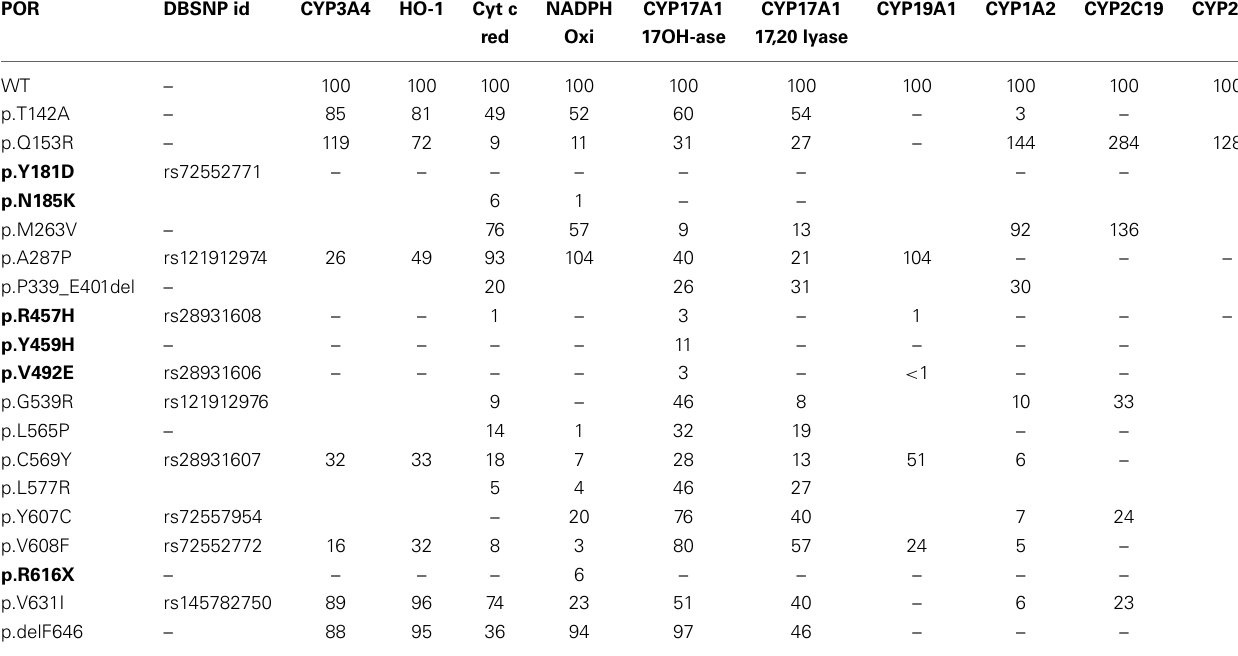
Table 2 | Influence of POR variants found in patients with disorder of sexual development, on the enzyme activities of its redox